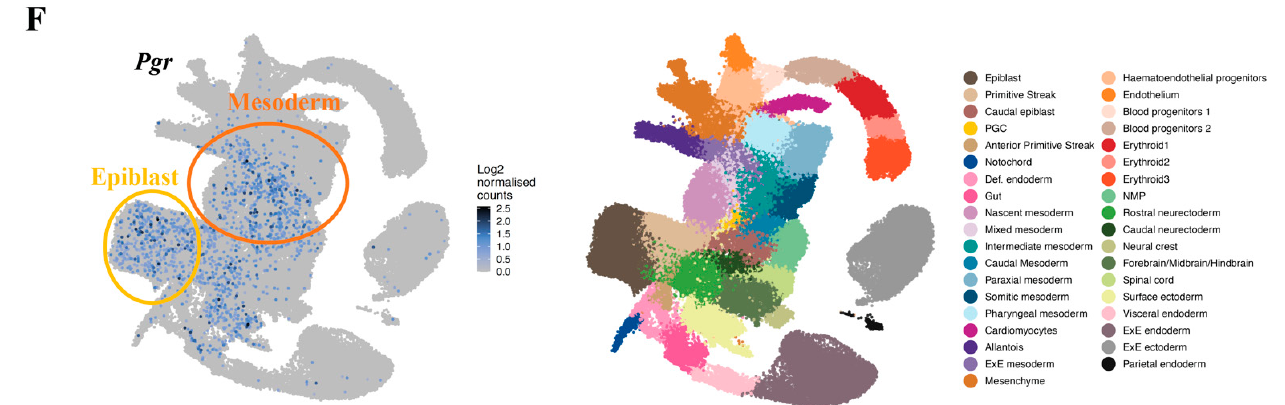
Figure 1. Identification of PGR as a TF candidate involved in priming EpiSCs towards mesoderm fate. ( A ) Schematic representation of E6.5–7.0 gastrulating mouse embryo. Epiblast cells (yellow) ingress and become the posterior (PPS, light red) and/or anterior (APS, grey) primitive streak (PS). Cells originating in different regions of the PS display distinct mesodermal fate bias. Extraembryonic mesoderm (dark red) including blood (hemangioblast) and allantois originate from PPS, while APS will give rise to cardiac mesoderm (green), paraxial mesoderm (blue), and definitive endoderm (pink). The coordinated activity of different signaling pathways (NODAL, WNT, and BMP) activate specific transcriptional programs that direct mesodermal fate. ( B ) Illustration summarizing the protocol used to differentiate EpiSCs towards PPS and APS cells and their derivatives, cardiac mesoderm (CM) and paraxial mesoderm (PM) progenitors. ( C ) Heatmap of RNA-Seq of EpiSCs, PPS, and APS delineating the antero-posterior identity of the in vitro-generated cell populations. PPS cells are enriched in extraembryonic markers and known BMP target genes ( Evx1 , Bmp4 , Hand1 , Foxf1 , and Tbx3 ), while APS cells show high levels of anterior PS markers ( Gsc , Sox17 , Tbx6 , Eomes , and Foxa2 ). ( D ) Identification of 19 TFs specifically enriched in EpiSCs by comparing RNA-Seq data of EpiSCs with mouse ESCs cultured in 2i/LIF and serum/LIF. ( E ) Heatmap showing the expression of the six short-listed TFs in different cell types. Blc11b and Pgr exhibit a distinct pattern of expression, with the highest levels of mRNA found in EpiSCs, PPS, and APS (highlighted by arrows), (RNA-Seq, p ≤ 0.05, fold-change ≥ 1.5). ESC, embryonic stem cells; EpiSC, epiblast stem cells; PPS, posterior primitive streak; APS, anterior primitive streak; ExM, extraembryonic mesoderm; CM, cardiac mesoderm; PM, paraxial mesoderm. ( F ) UMAP visualization and clustering of scRNA-Seq of gastrulating mouse embryos showing Pgr expression in the epiblast (yellow circle) and mesoderm (brown circle) (data set obtained from Pijuan-Sala et al. Nature 2019 [21]).